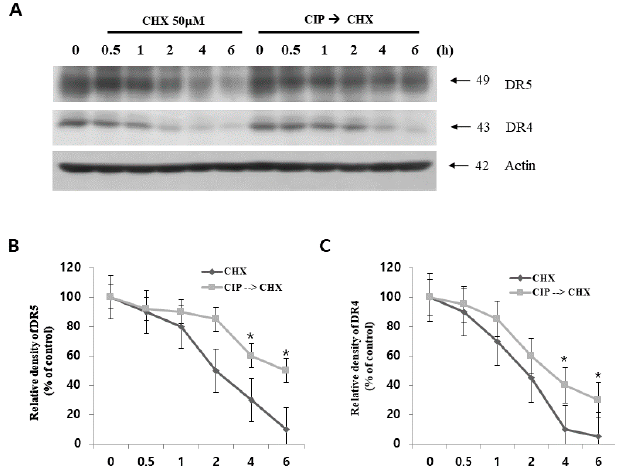
Figure 6. Effect of CIP on DR4 and DR5 protein stability. ( A ) A549 cells were treated with or without CIP for 24 h in the presence or absence of CHX for the indicated time periods. DR5, DR4, and actin protein levels were determined by western blotting. Actin was used as a loading control. The band intensity of DR5 ( B ) and DR4 ( C ) proteins was measured using the public domain JAVA image-processing program Image J. Each value represents the mean ± SD of three independent experiments. * p < 0.05 compared to that of